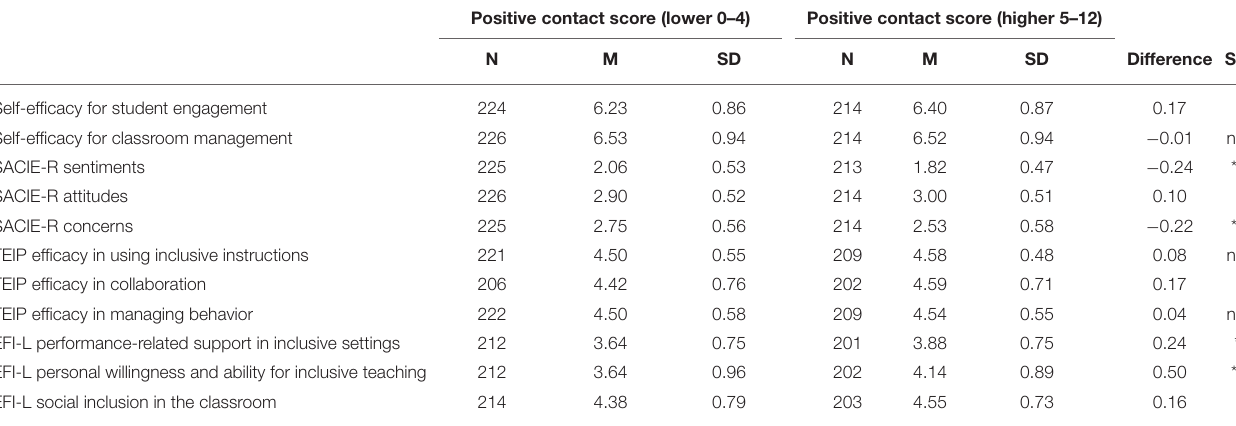
TABLE 2 | Group comparison at measurement time t0: low contact intensity vs. high contact intensity. Positive contact score (lower